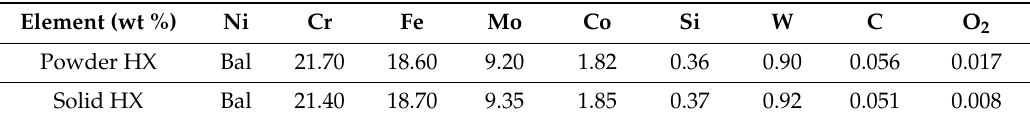
Table 1. Chemical composition of the main elements obtained by inductively coupled plasma-optical emission spectroscopy (ICP-OES), infrared absorption (IRA) and inert gas fusion (IGF) analyses on powder and solid (post-processed) HX samples.